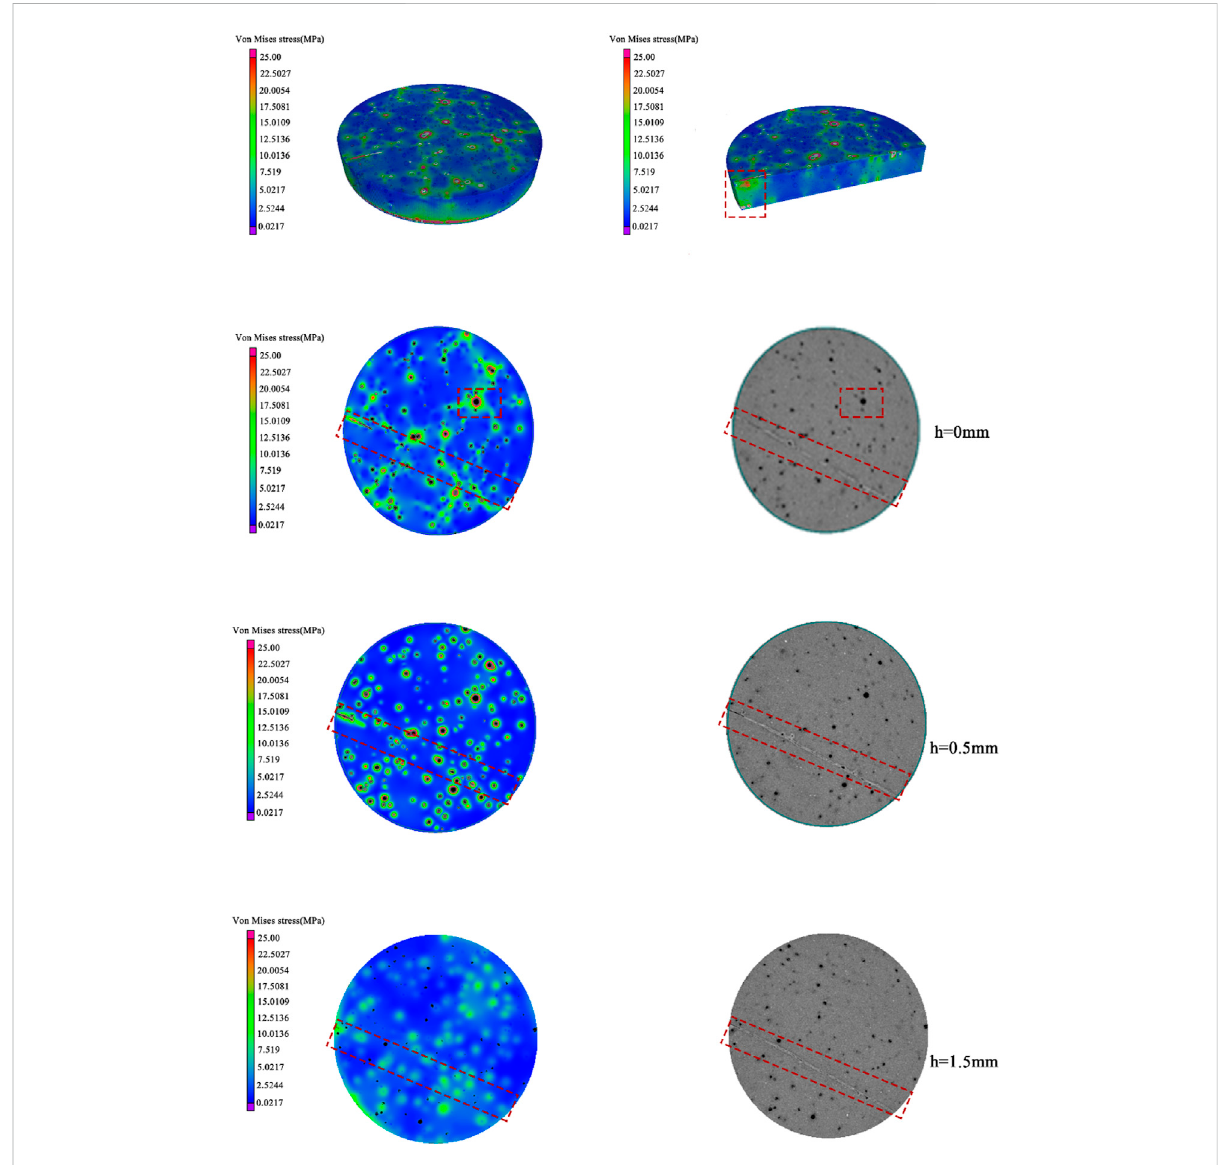
FIGURE 10 Von mises stress distribution of the healed cement